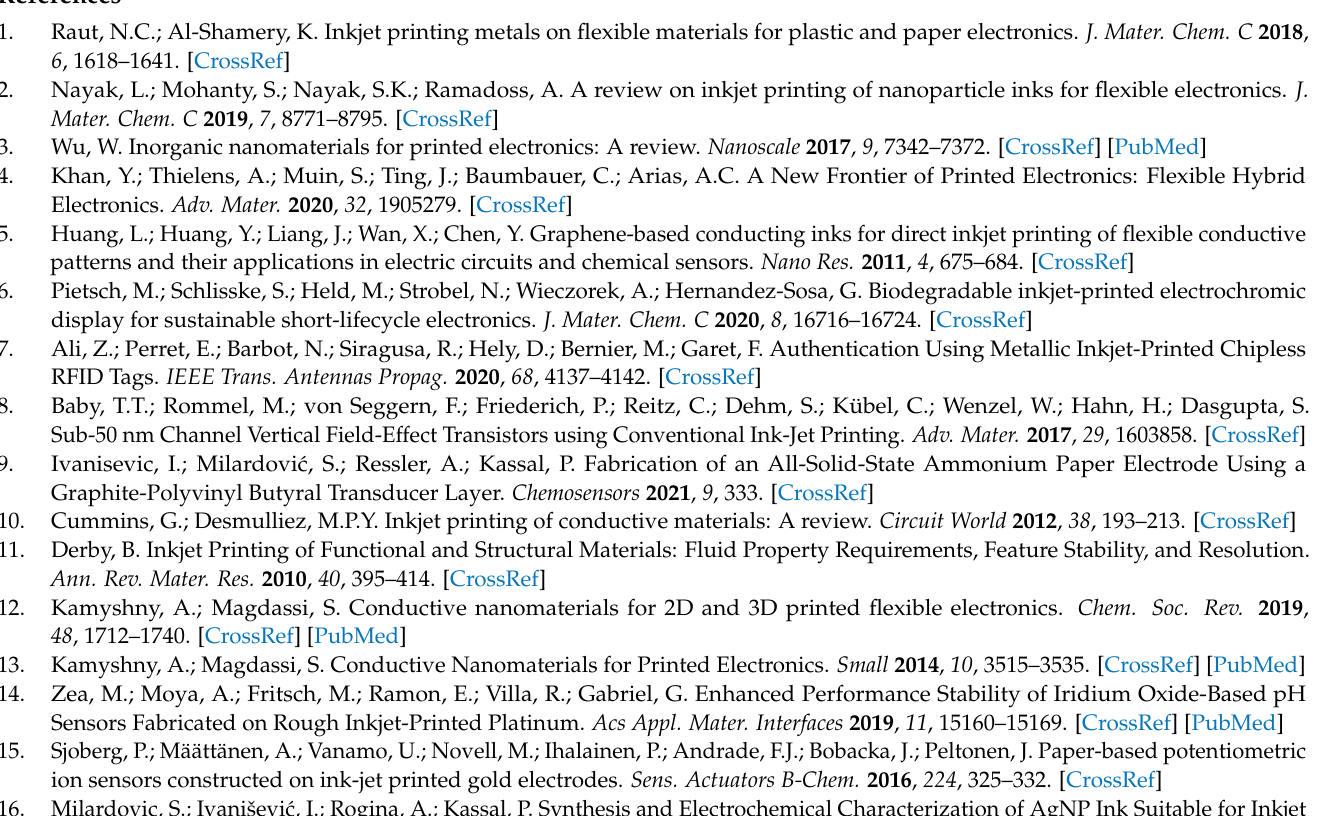
Figure S4: Thermogravimetric analysis; Figure S5: Effect of intense pulsed light on sheet resis- tance; Table S1: Optimized printing parameters; Table S2: An overview of relevant literature.